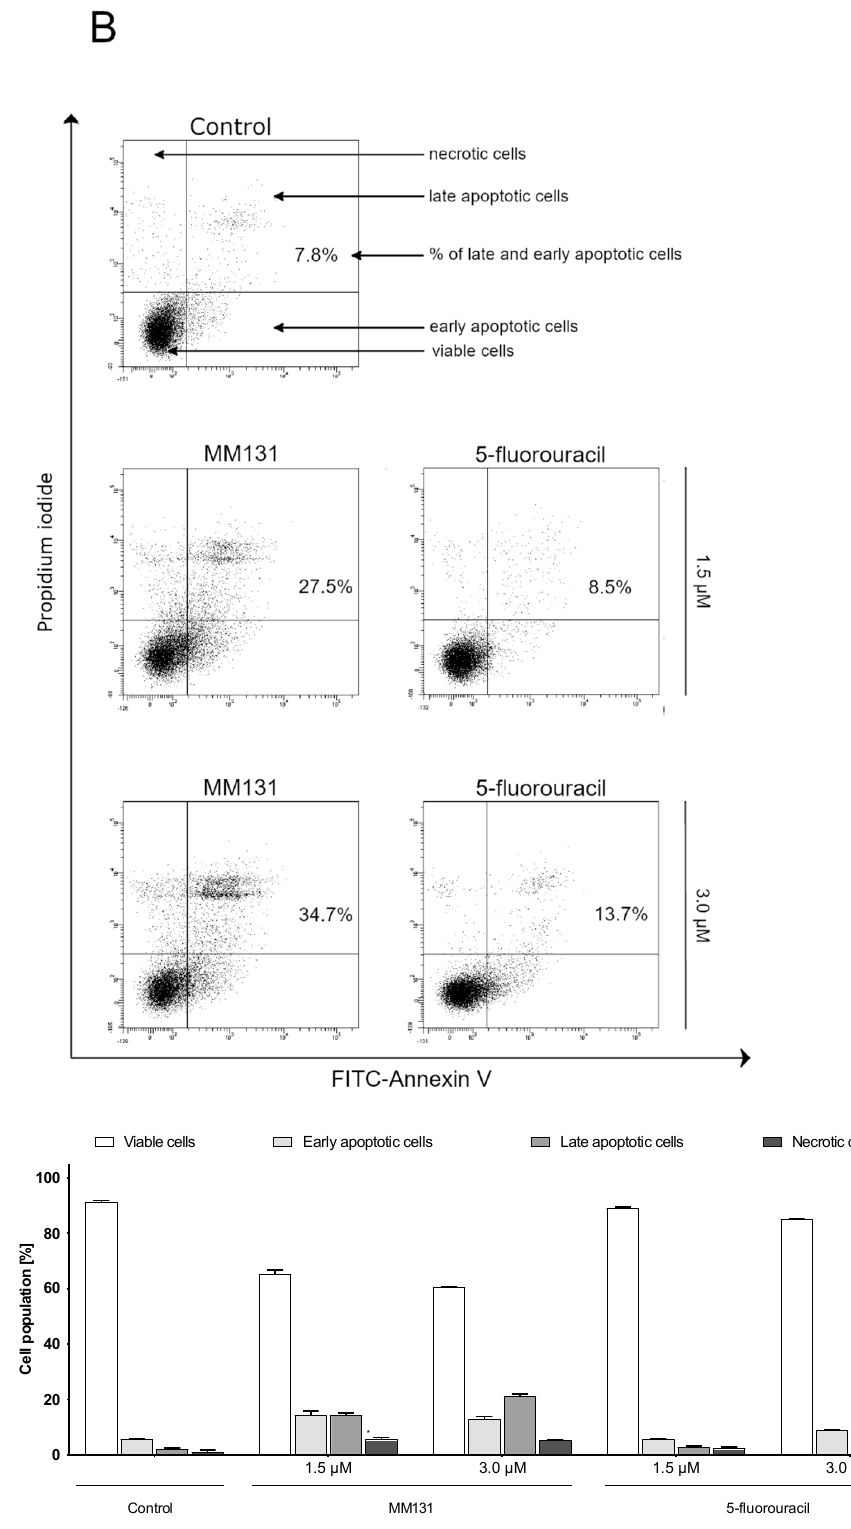
Figure 3. Apoptosis measurement by flow cytometry with Annexin V-FITC staining in DLD-1 ( A ) and HT-29 ( B ) exposed for 24 h to MM131 and 5-fluorouracil. Left bottom square has live cells, right bottom early apoptotic cells, the superior left square contains necrotic cells, and superior right late apoptotic cells. The apoptotic rate of the compounds is presented as a sum of mean percentage of early- and late-apoptotic cells in the adequate cell line ( n = 3 in